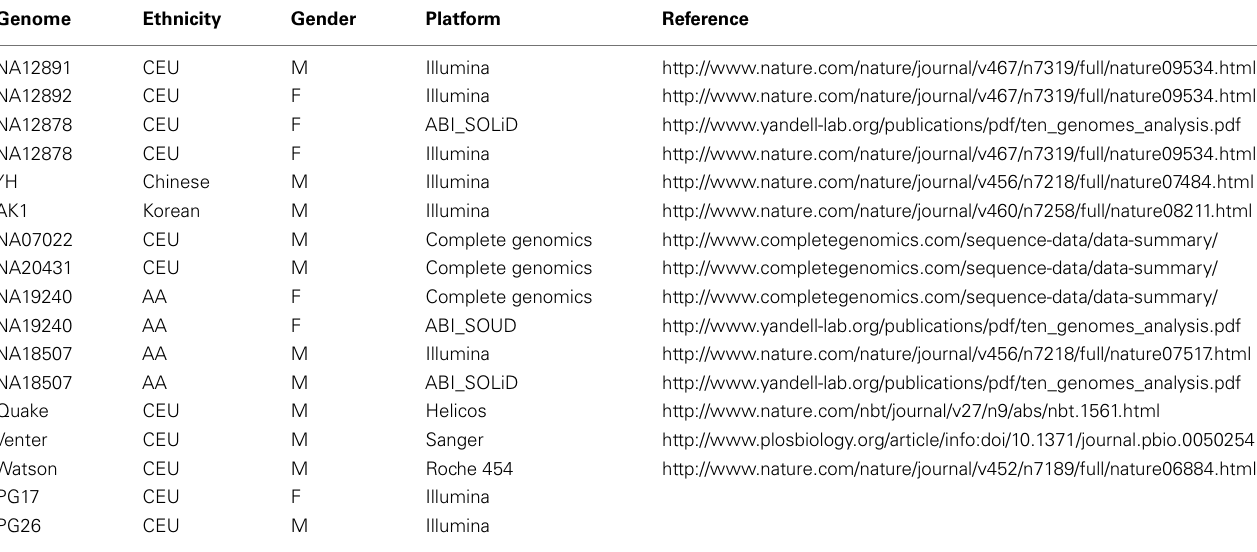
TableA2 | List of genome sequences that were used for comparisons with PG17 and PG26. Genome Ethnicity Gender Platform